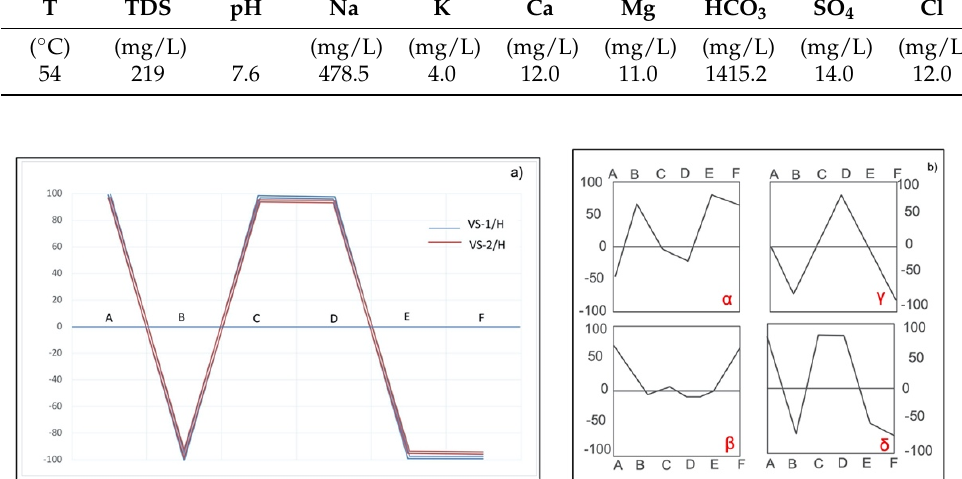
Legend for Figure 10a: A—indicates that geothermal waters had circulated through calcareous terrain rather than an evaporative one; B—indicates that this geothermal water, highly rich in sodium, may have come from sedimentary terrain; C—indicates that the geothermal water may have circulated through flysch sediments; D—excludes water circulations through dolomite; E— indicates the geothermal water had circulated in a sulfated reservoir rather than a carbonated reservoir; F—indicates no in growth of potassium content, which excludes possible circulation in a granitic field Figure 10. ( a ) D’Amore parameters diagram of chemical analyses from Table 3; ( b ) α : evaporative terrains; β circulation in limestone; γ : circulation through a crystalline basement; δ : circulation in argillaceous rocks.